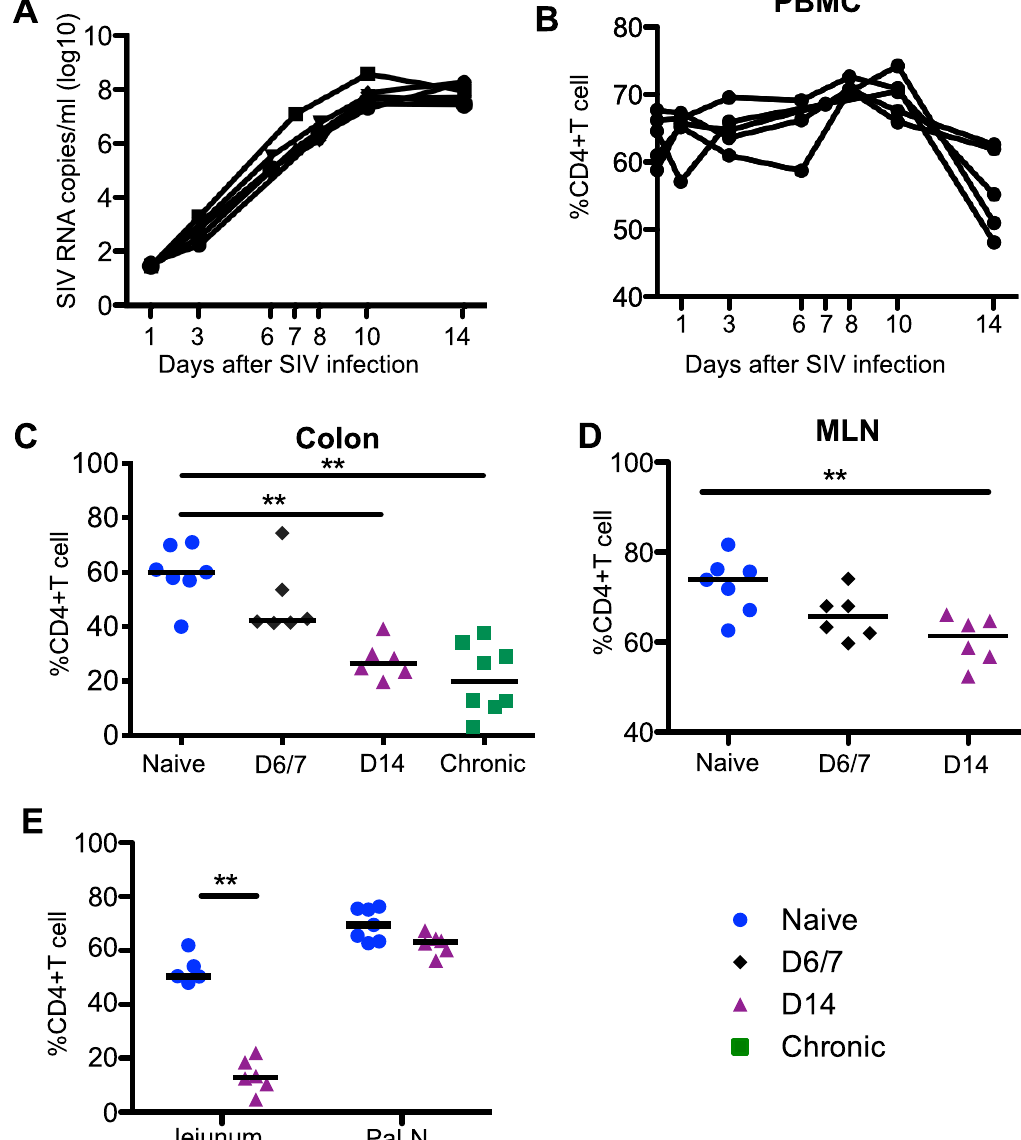
Fig. 1. Plasma viremia and CD4 + T cell dynamics in SIV infection. (A) Kinetics of plasma viral load during acute SIV infection. Percentages of CD4 + T cells among total CD3 + T cells in blood (B), colon (C), MLN (D), and jejunum and PaLN (E). Statistical comparisons are between naı¨ve and acutely infected macaques at the indicated time points. Mann-Whitney U test; * p , 0.05, ** p , 0.01, *** p , 0.001. MLN and PaLN; mesenteric and pararectal/ paracolonic lymph nodes, respectively. Samples are from naı¨ve macaques (n=7) and those sacrificed at day 6/7 (n=6), day 14 post-infection (n=6), and those sacrificed in chronic disease (n=8).